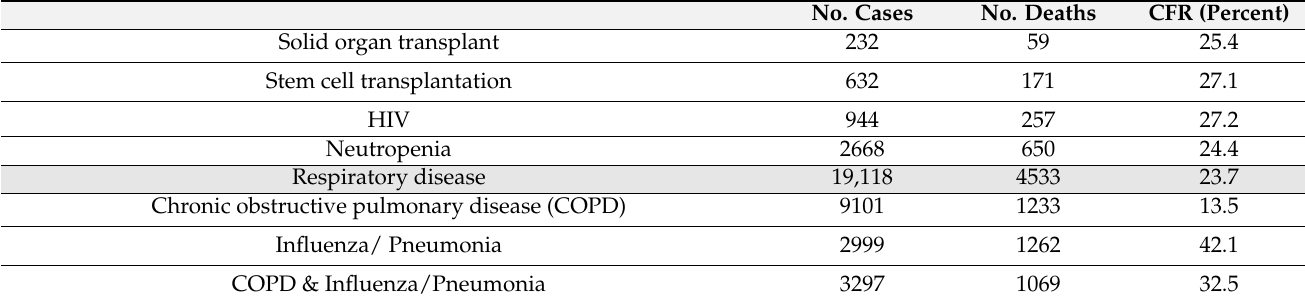
Table 2. CFRs by main comorbidities in aspergillosis inpatients.